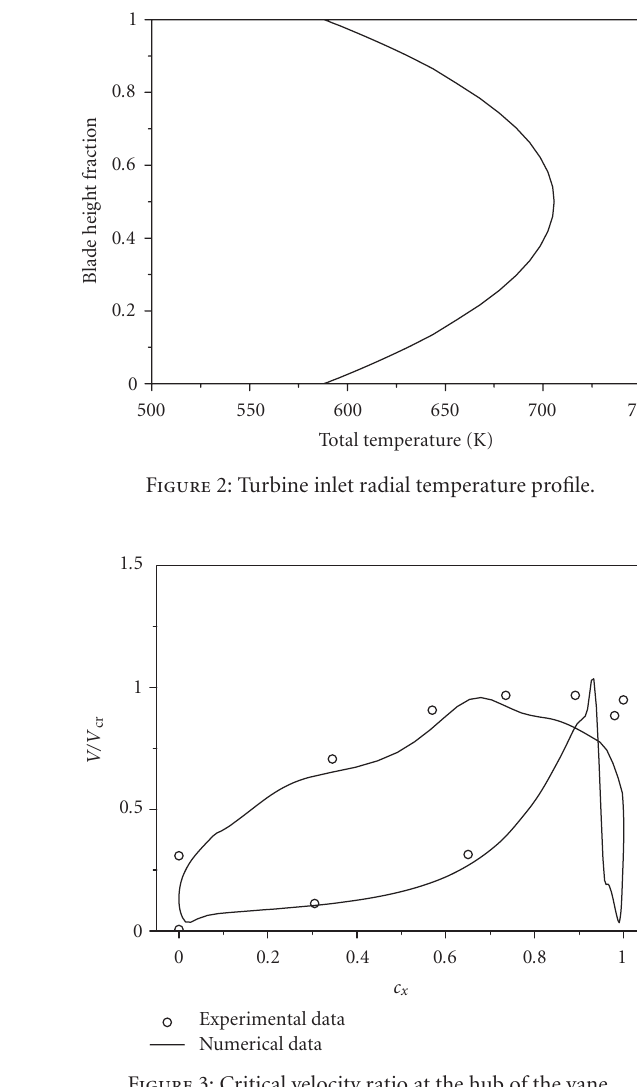
Figure 3: Critical velocity ratio at the hub of the